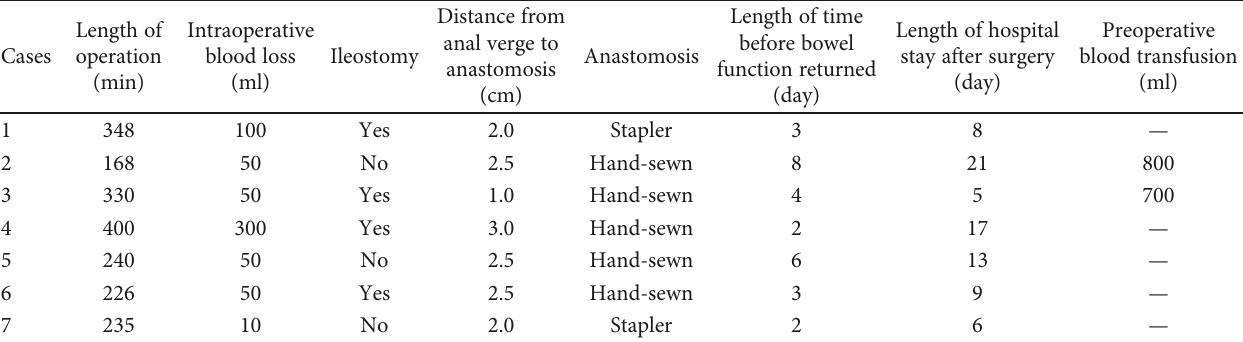
Figure 4: MRI fi ndings of DCHR. (a) Thickened rectal wall and serpentine vessel. (b) Enlarged and serpentine vessel. (c) Serpentine vessel. (d) Thickened rectal and anal canal wall. Table 2: Detailed treatment information of the 7